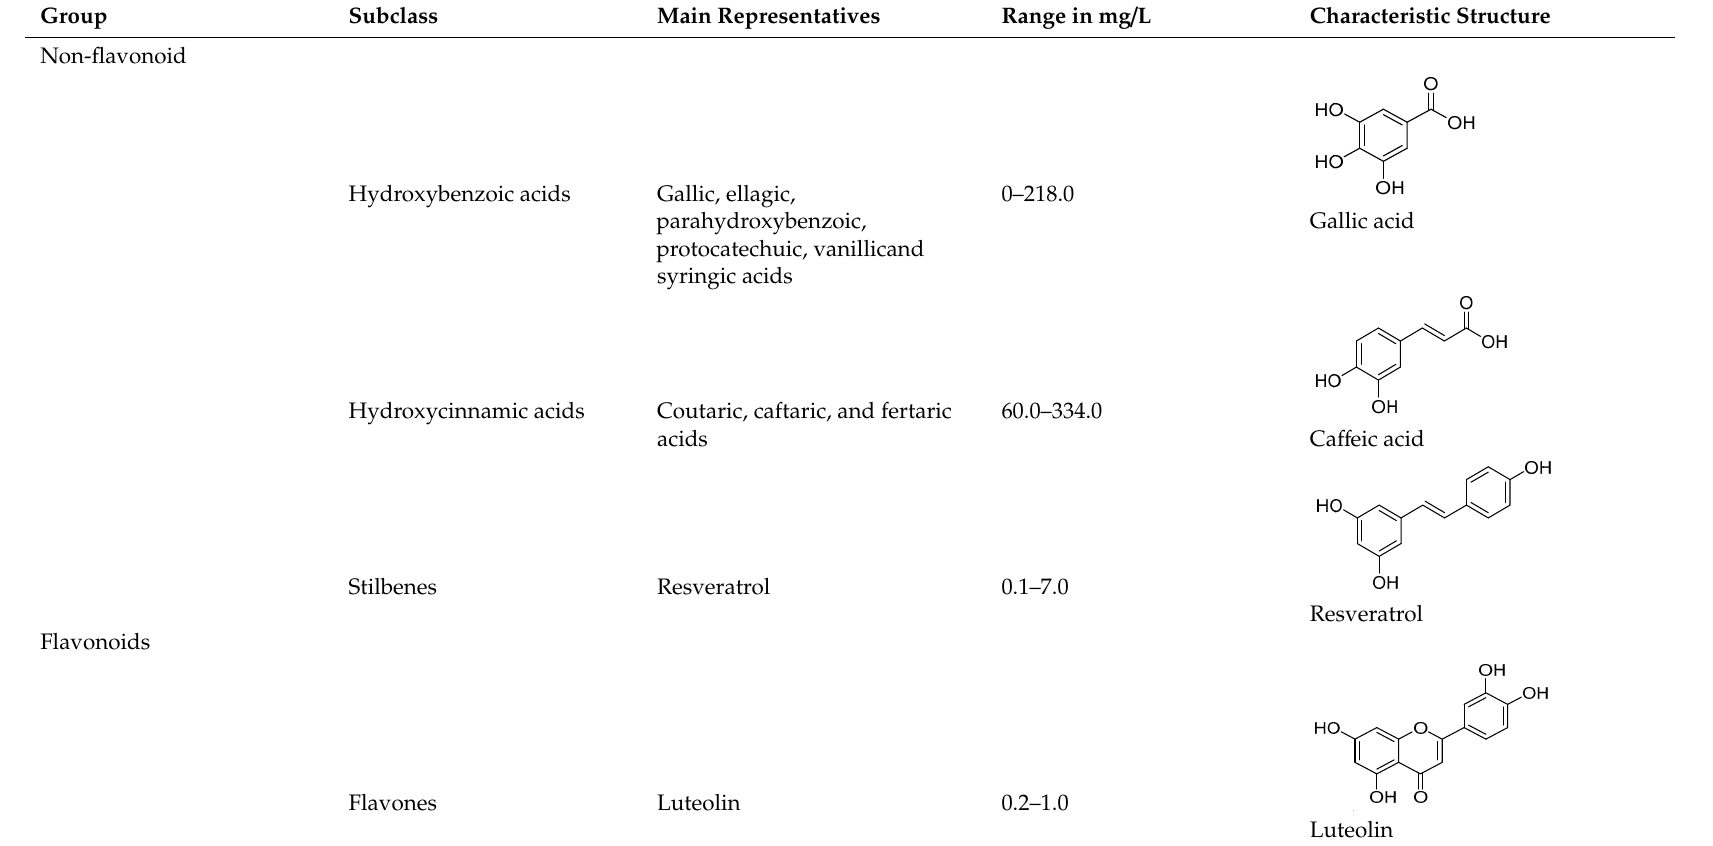
Table 1. Main representative groups of polyphenols present in red wine [67–69,77,94–96].